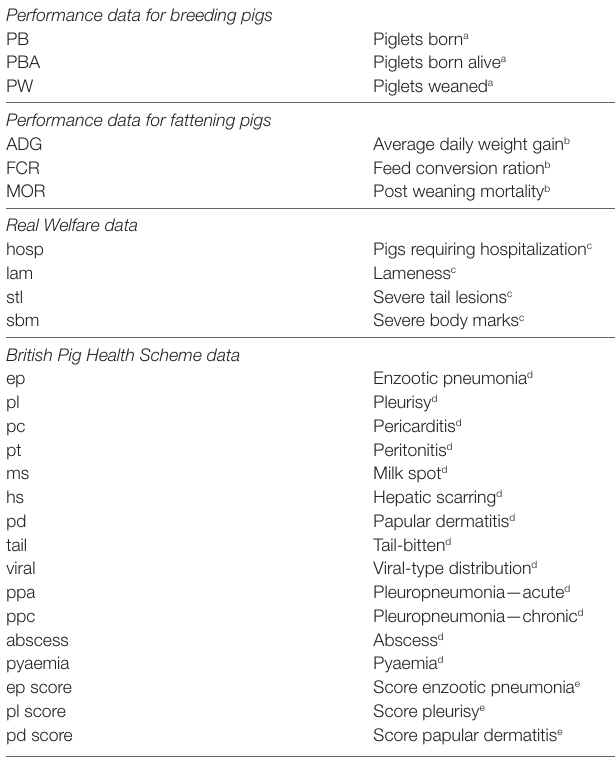
TaBle 1 | Production data for the study farms, collected during a farm visit, and health and welfare indicator data collected from the British Pig Health Scheme and Real Welfare databases of Agricultural and Horticultural Development Board